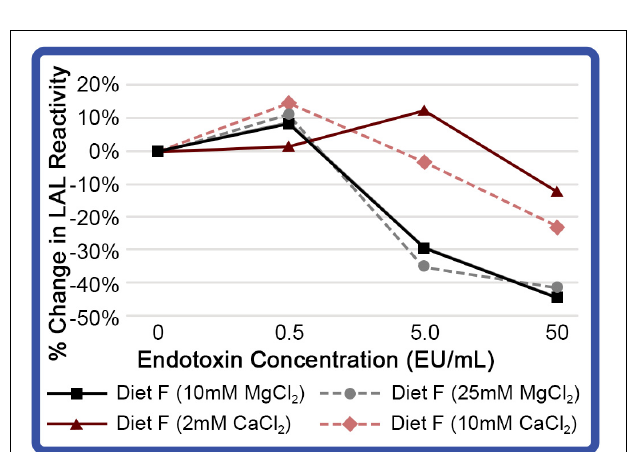
FIGURE 10 | Effect of different cations on reactivity of aquaculture LAL at different endotoxin concentrations. LAL extract (300 µ g) derived from HSCs fed Diet F in Feed Study 3 analyzed to determine effect of MgCl 2 (10 and 25 mM) and CaCl 2 (2 and 10 mM). LAL was incubated with a range of endotoxin concentrations (0 – 50 EU/mL) for 1 h at 37 ◦ C. Background absorbance was subtracted from each at 0 EU/mL, as addition of CaCl 2